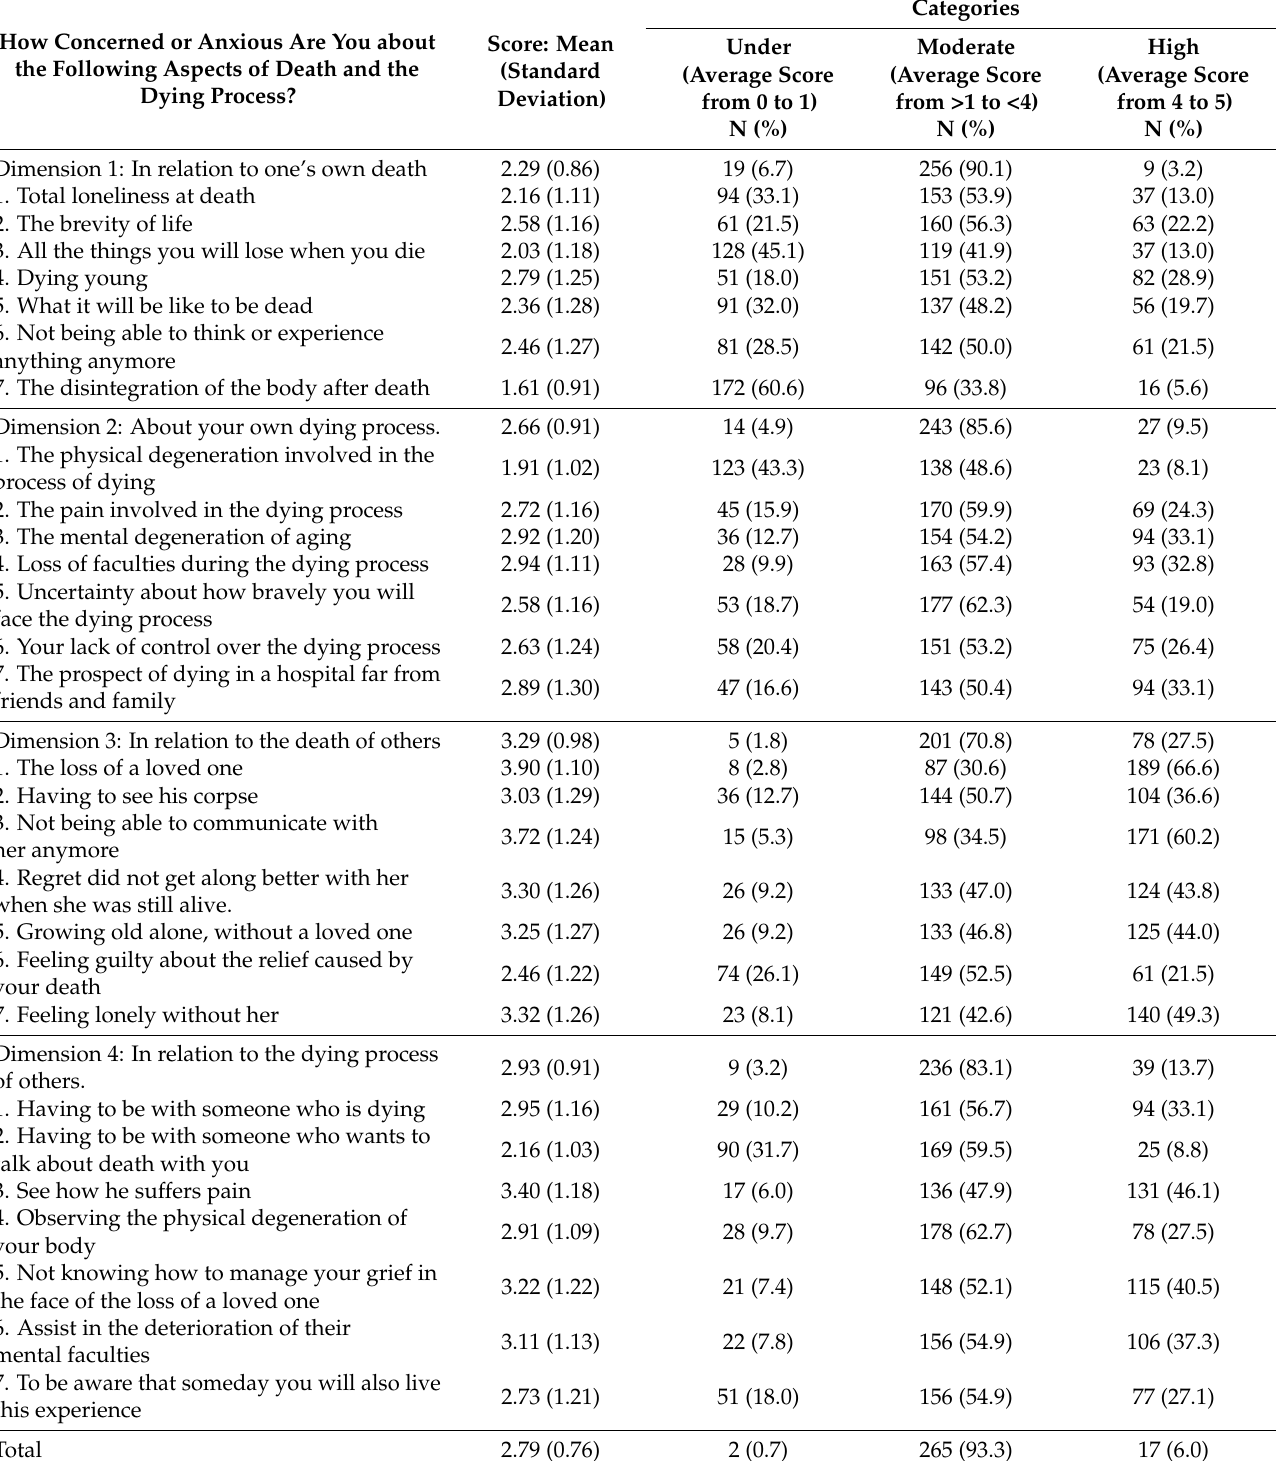
Table 2. Collet–Lester fear-of-death